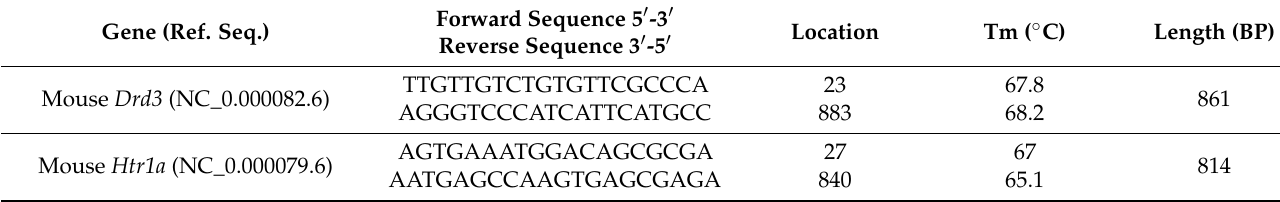
Table 2. PCR primers used to amplify the mouse Drd3 and Htr1a genes. Gene (Ref.